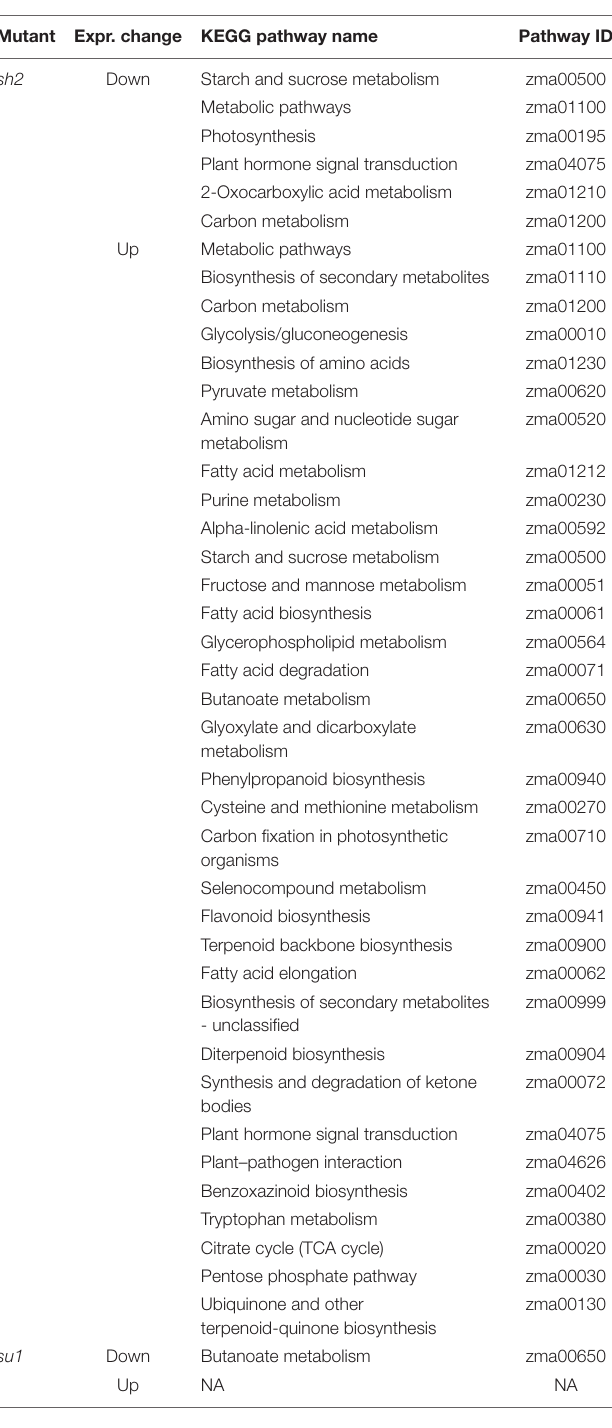
TABLE 1 | KOBAS pathway enrichment results. Mutant Expr. change KEGG pathway name Pathway ID